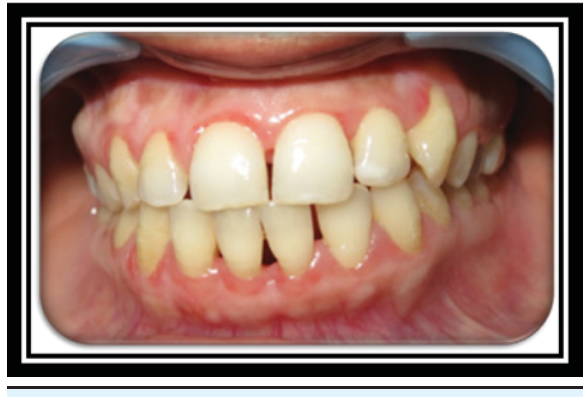
Figure 4. After 4 weeks of periodontal therapy